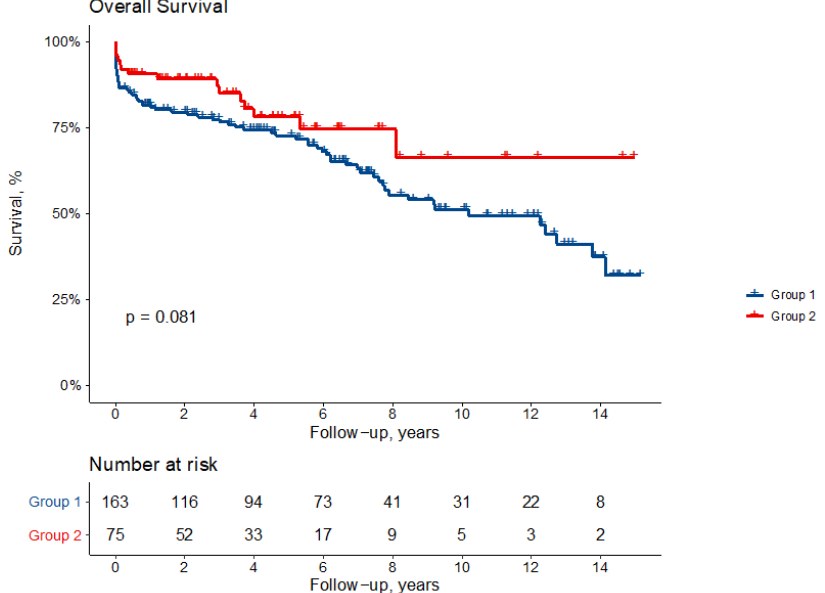
Figure 1. Actuarial survival following repair of type A acute aortic dissection according. to the type of initial repair: ascending hemiarch replacement (Group 1) or arch replacement (Group 2).